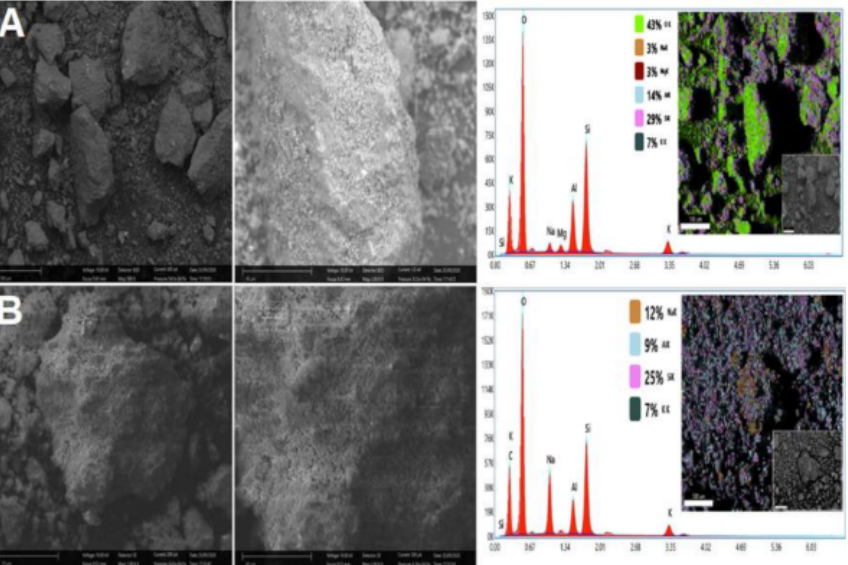
Figure 7. SEM-EDS of the treated materials indicating their elemental distribution: ( A ) EL01 and ( B ) EL01H observed at 100 µ m and 40 µ m. (K: potassium, Si: Silicium, Na: Sodium, Mg: Magnesium, Al: Aluminium and O: